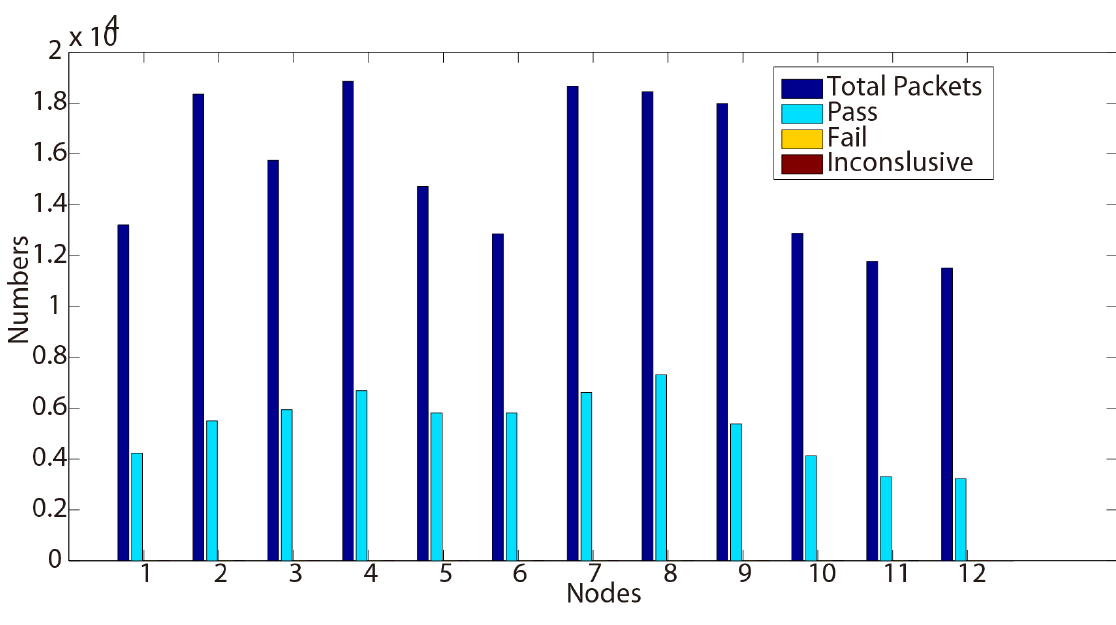
Figure 3. Test results for Property 2 (Day